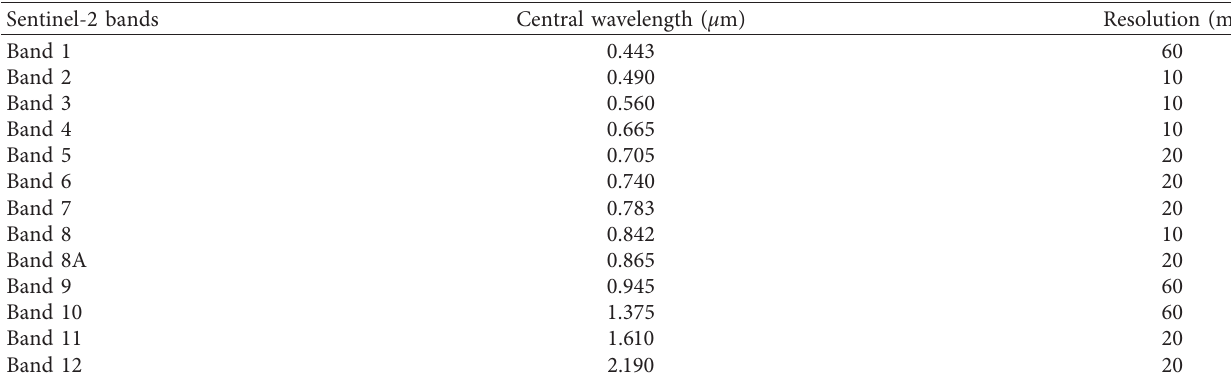
Figure 1: Location map in Liaodong Bay of Bohai Sea in China. Table 1: The central wavelength and resolution of